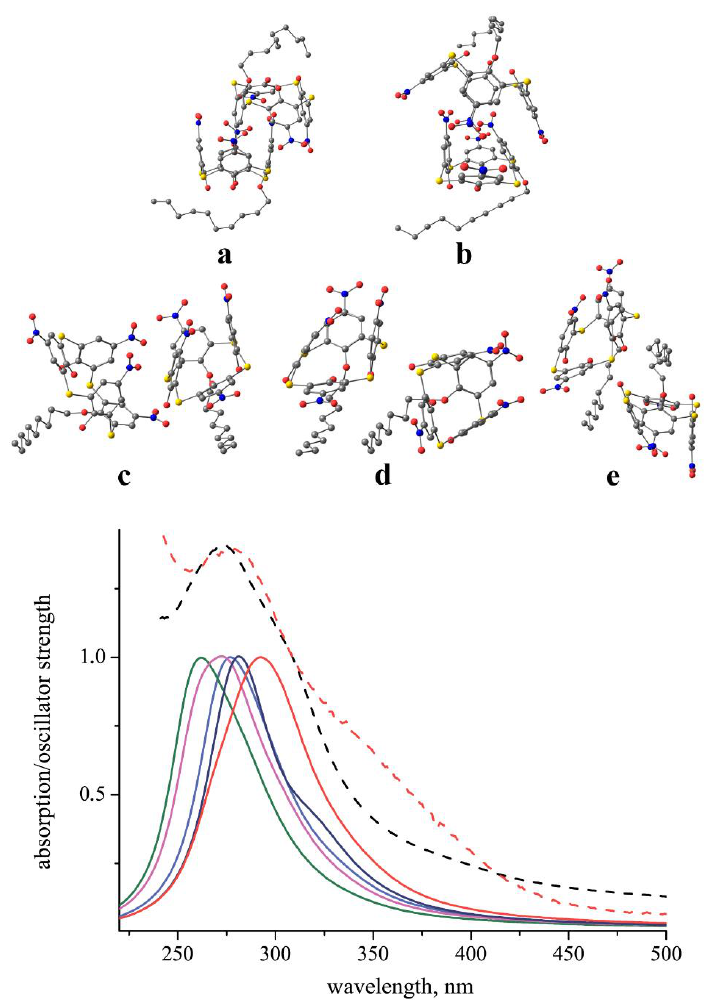
Figure 12. ( Top ) Quantum chemically optimized dimer models; ( Bottom ) Quantum chemically simulated absorption spectra of dimer models a (red), b (black), c (blue), d (magenta), and e (green) as compared with experimental spectra in dichloromethane, C = 10 − 5 mol · L − 1 (dashed, black), and in film on quartz (dashed, red).